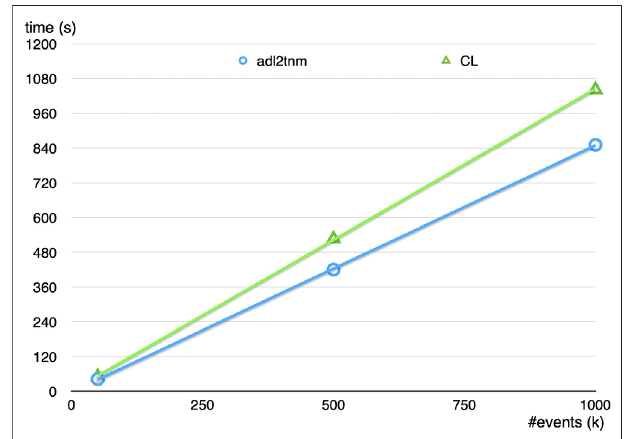
FIGURE 2 | Speed comparison of CutLang versus the C++ ADL transpiler adl2tnm on a CMS supersymmetry analysis (CMS et al., 2019)